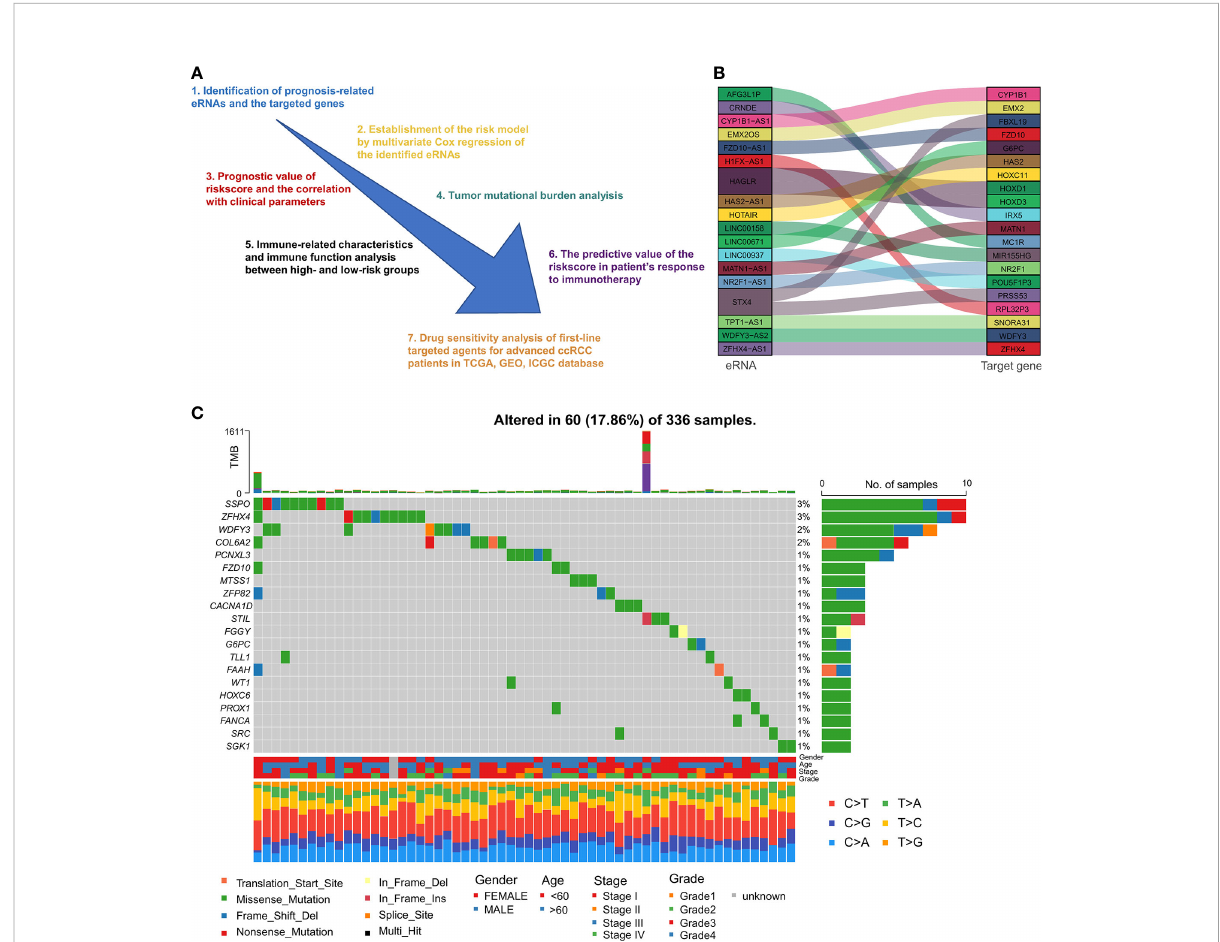
FIGURE 1 Flow chart and identi fi cation of prognostic eRNAs: (A) Diagram showing the methodology of this study. (B) Top 20 correlated eRNAs and their target genes relevant to survival. (C) The top 20 mutated eRNAs or target genes associated with patient